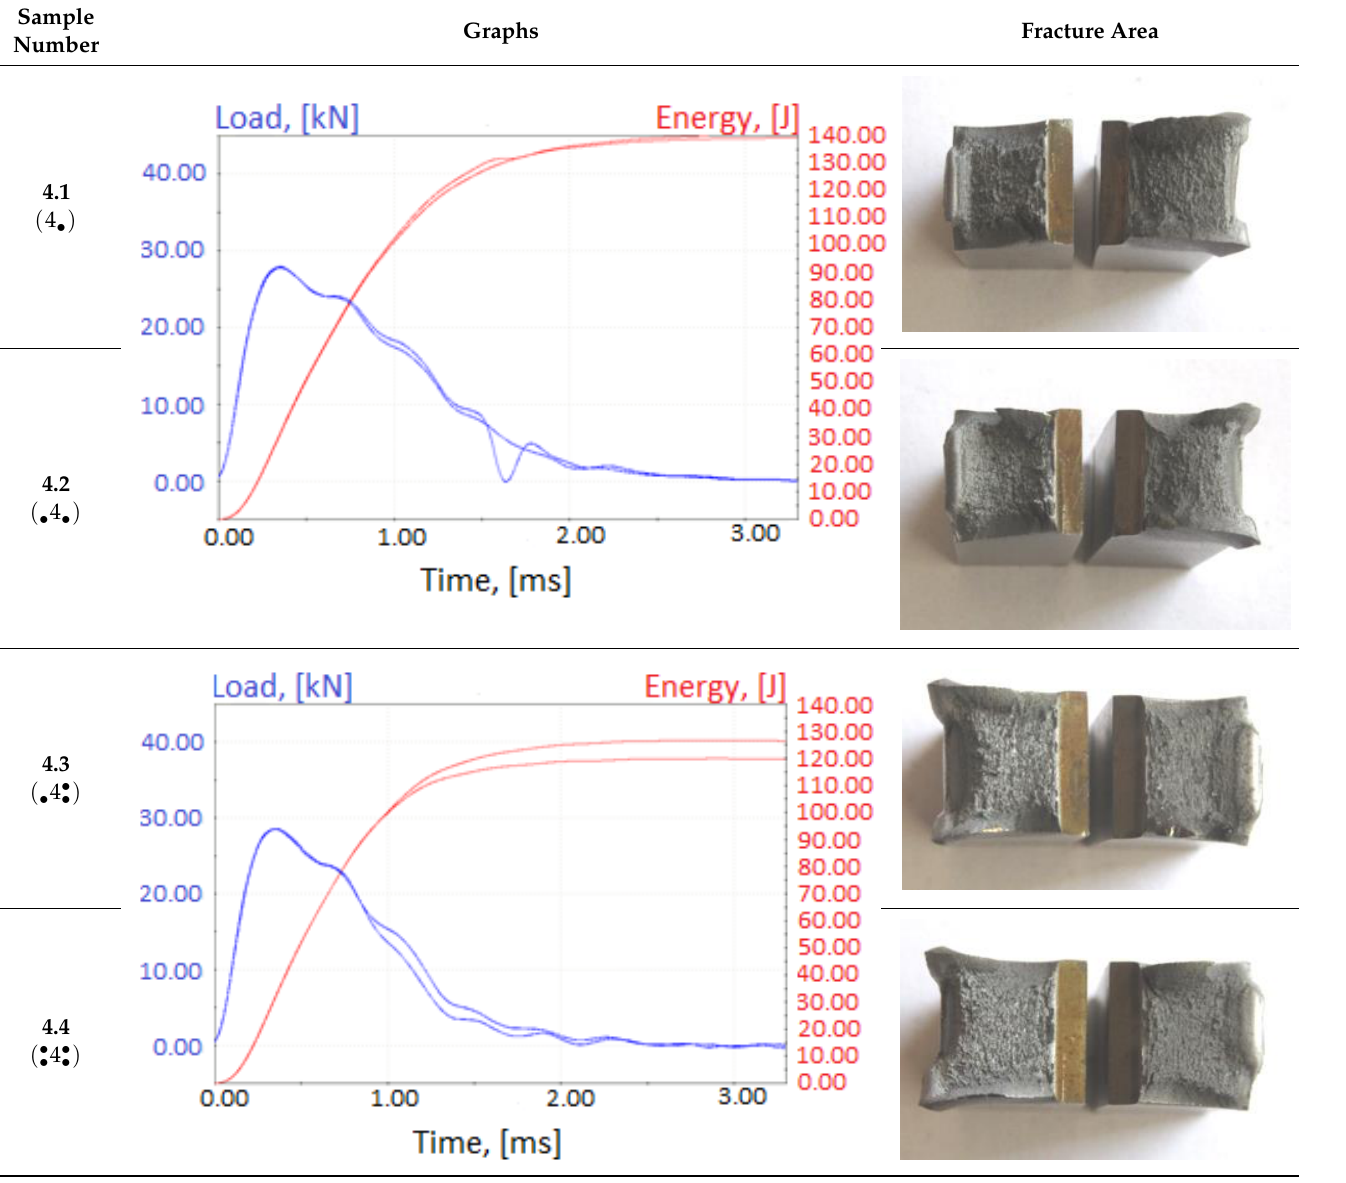
Table 8. Experiment results: impact energy, hardness, yield and tensile strength.